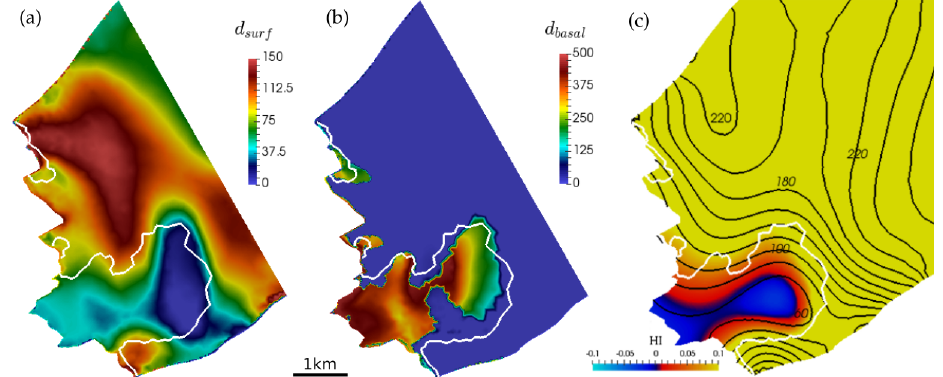
Figure 6. (a) Surface crevasse penetration and (b) basal crevasse penetration from the beginning of the control simulation. (Note different colour scale.) (c) Hydrostatic imbalance (Eq. 1) at the terminus and 20m surface elevation contours (black lines). White line indicates the grounding line. Figure S4 shows the equivalent panels for the mélange season, indicating that these patterns are permanent features of the